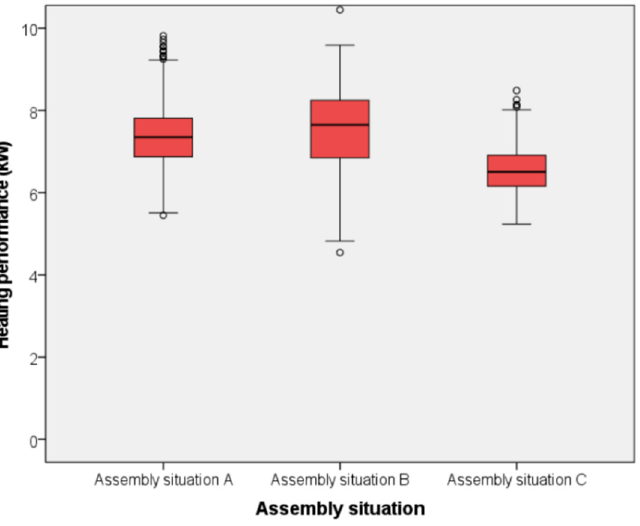
Figure 7. Comparison of the heating performance of the heat exchanger for the three assembly situations A, B, and C (cf. Figure 3) in the exchange scrubber that were investigated.